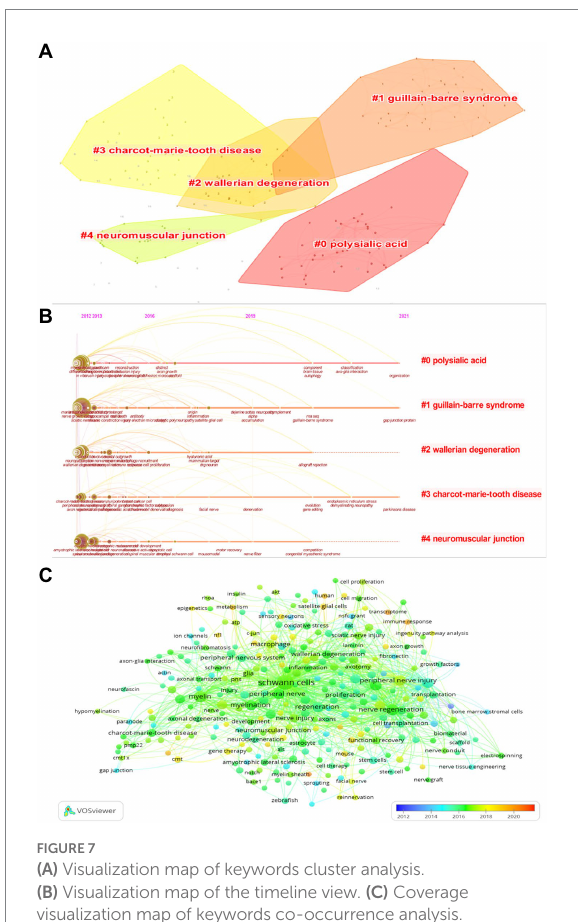
FIGURE 7 (A) Visualization map of keywords cluster analysis. (B) Visualization map of the timeline view. (C) Coverage visualization map of keywords co-occurrence analysis.